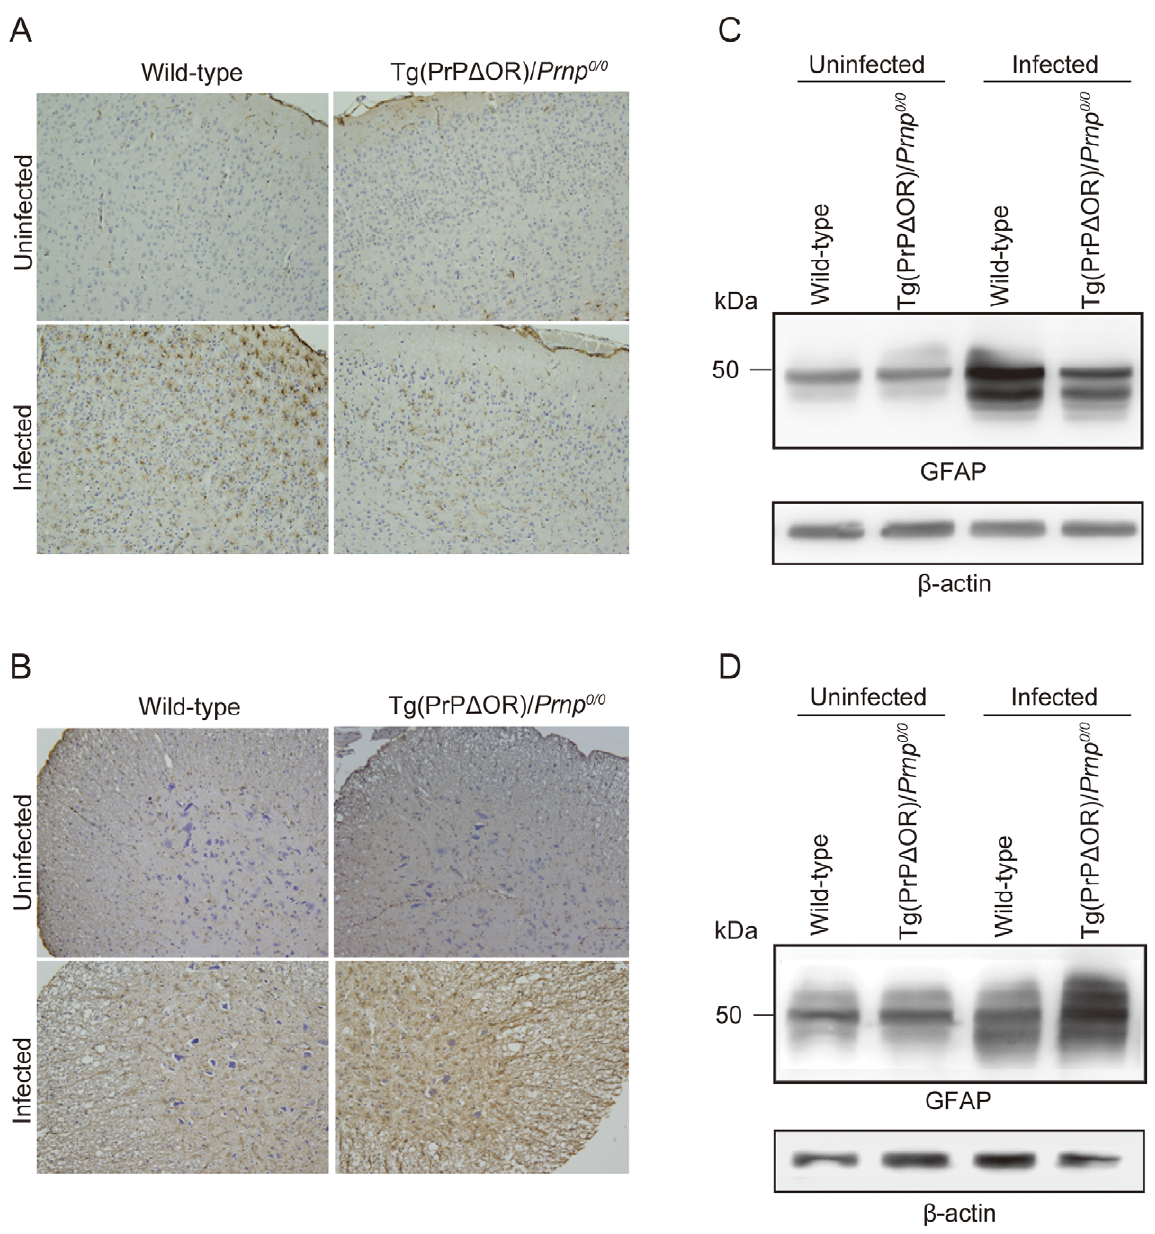
Figure 2. Astrogliosis in the brains and cervical cords of tg(PrP D OR)/ Prnp 0/0 mice infected with RML prions. The cerebral cortices (A) and cervical cords (B) of uninfected or terminally ill wild-type and tg(PrP D OR)/ Prnp 0/0 mice were immunohistochemically stained with anti-GFAP antibodies. The signals were milder in the brains of terminally ill tg(PrP D OR)/ Prnp 0/0 mice, compared to those in control wild-type mice. No decrease in the signals was observed in the cervical cords of terminally ill tg(PrP D OR)/ Prnp 0/0 mice. Immunoblots of the homogenates of brains (C) and spinal cords (D) of uninfected and terminally ill wild-type and tg(PrP D OR)/ Prnp 0/0 mice using anti-GFAP antibodies are shown. Terminally ill tg(PrP D OR)/ Prnp 0/0 mice expressed GFAP in their brains less than control wild-type mice. No reduction in the GFAP expression was detected in the spinal cords of terminally ill tg(PrP D OR)/ Prnp 0/0 mice. terminal residues 24–37 of PrP. The antibody reacted with the PK-resistant fragments from PrP Sc D OR but not from wild-type PrP Sc (Fig. 4B). We detected no PK-resistant fragments with molecular size . 2 kDa in the brains of terminally ill wild-type mice on Western blotting using IBL-N antibodies (data not shown). Taken together, these results suggest that the entire PrP Sc D OR, including the pre-OR residues is PK-resistant, while only the C-terminal part is PK-resistant in wild-type PrP Sc .